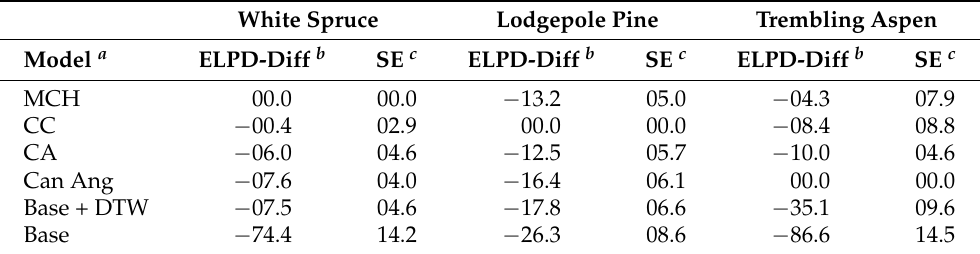
Figure 6. Summary showing Box-Whisker plots for all predictor variables as well as tree height growth rates for each species (LP: lodgepole pine; TA: trembling aspen; WS: white spruce). Red dots represent individual data points. Table 3. Summary of the differences in ELPD values for each species using different neighborhood crowding indices, based on the loo criterion. The model with highest ELPD-diff value is expected to have the best out-of-sample predictive